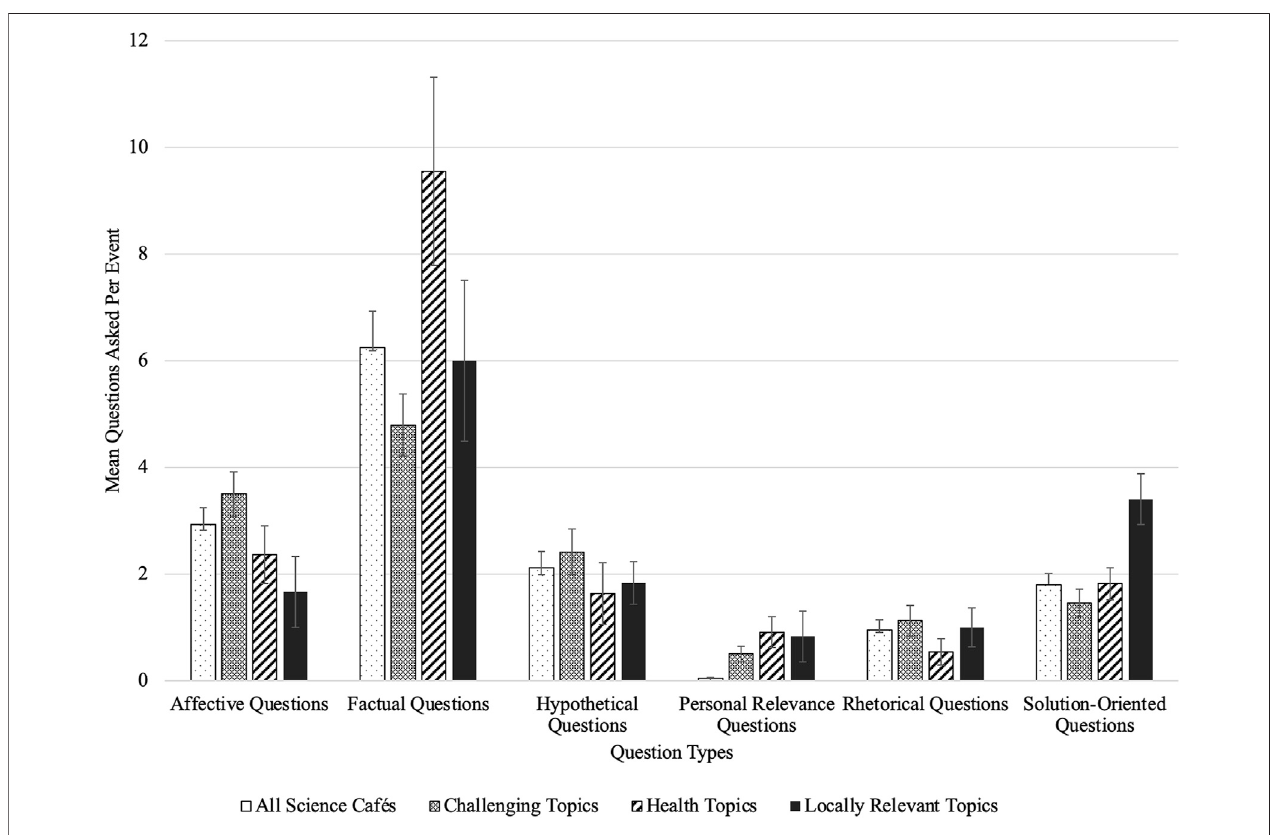
FIGURE 2 | Information-seeking question types for all Science Café